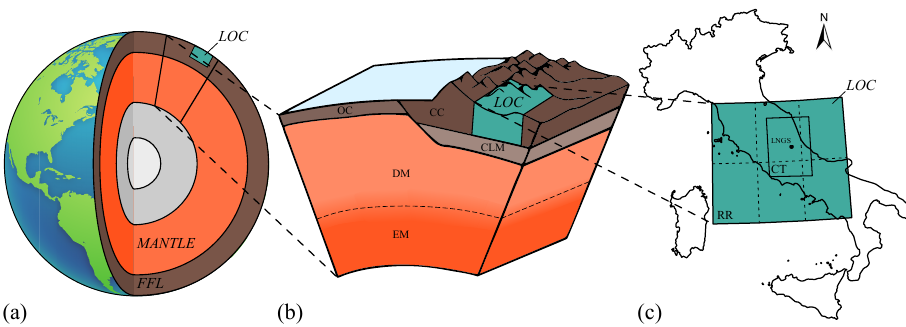
Figure 14. ( a ) Schematic drawing of the Earth’s structure, showing the three units contributing to the expected geoneutrino signal at LNGS: (i) the local crust (LOC), (ii) the far field lithosphere (FFL), and (ii) the mantle . The inner and outer portions of the core (in gray) do not contribute to the geoneutrino signal. Not to scale. ( b ) Schematic section detailing the components of the BSE. The lithosphere includes the LOC and the FFL. The latter comprises the rest of the continental crust (CC), the oceanic crust (OC), and the continental lithospheric mantle (CLM). In the mantle, two portions can be distinguished: a lower enriched mantle (EM) and an upper depleted mantle (DM). Not to scale. ( c ) Simplified map of the LOC. The central tile (CT) of the 2° 2° centered at LNGS is modeled separately × from the remaining six tiles which represent the rest of the region (RR). Figure taken from